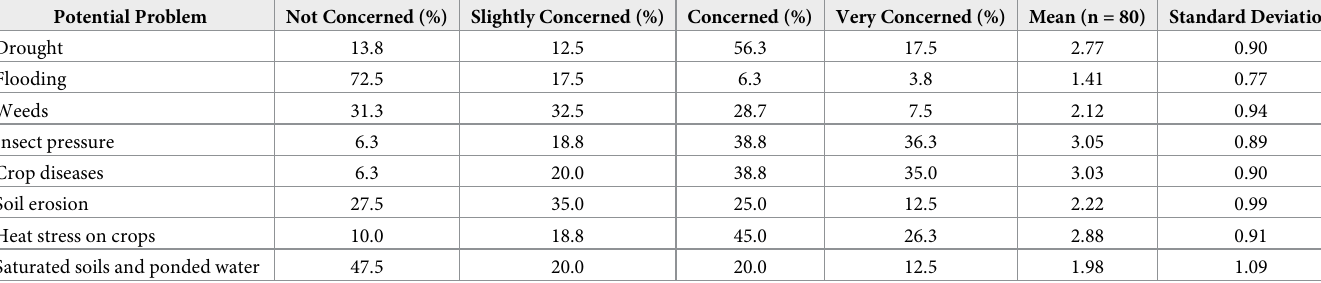
Table 4. Frequency distribution of the farmers’ concerns about adverse impacts of climate change. Potential Problem